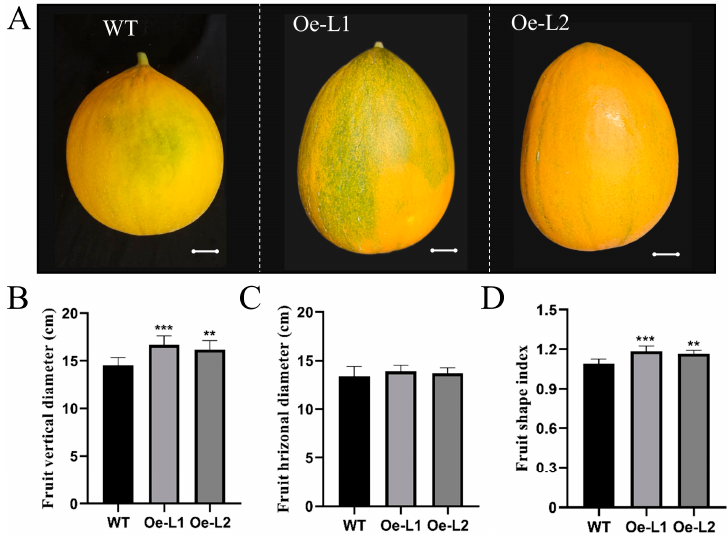
Figure 8. Phenotypic analysis of CmSUN23-24 -overexpressed transgenic lines. ( A ) Phenotypic observation of the fruits in transgenic lines. ( B ) Fruit vertical diameter significantly increased in transgenic lines. ( C ) Fruit horizonal diameter comparison between transgenic lines and WT. ( D ) Statistical analyses of fruit shape index in transgenic lines and WT. Scale bars = 2 cm. Oe-L1 and Oe-L2 indicate CmSUN23-24 -overexpressed transgenic lines. ** p value < 0.01; *** p value < 0.001.